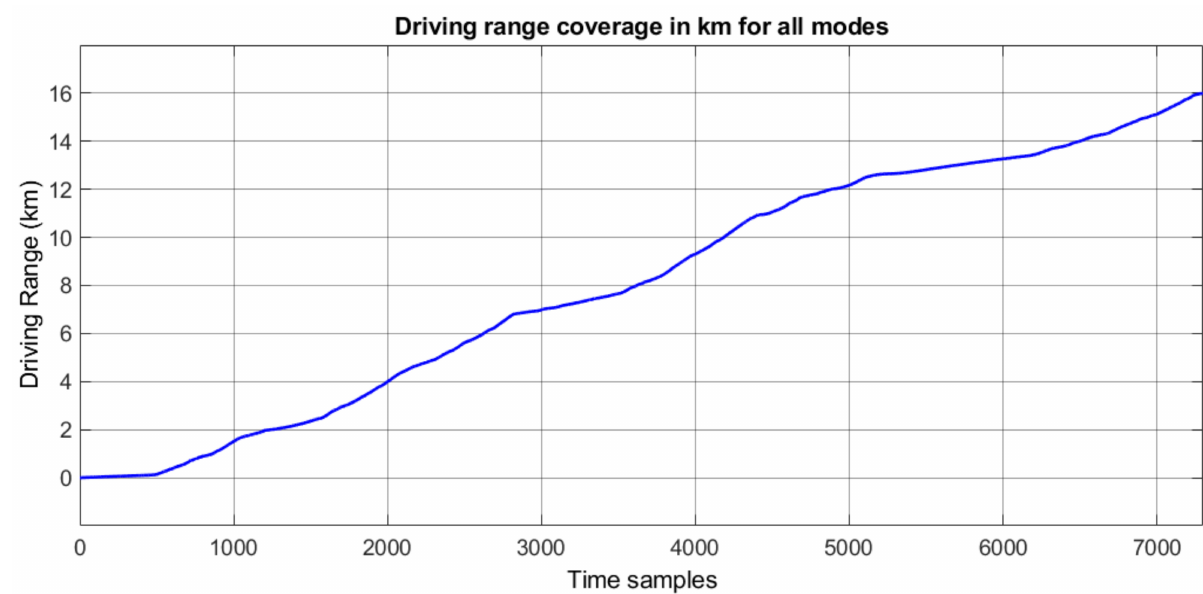
Figure 17. Simulation results for SoC during HEV mode.